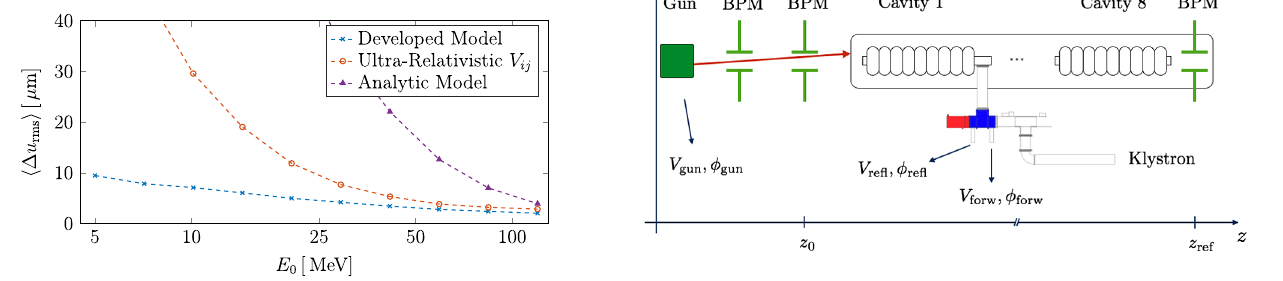
FIG. 6. Schematic drawing of the experimental setup at the FIG. 5. Rms difference between the output of the model injector section at FLASH. Two BPMs are located in the drift function and an ASTRA tracking h Δ u as a function of initial space between the gun and the first cavity. The last BPM is rms i beam energy E 0 , evaluated for one cavity and averaged over both located inside the cryogenic vessel and gives the reference offset. transverse planes. The beam transport matrices are calculated with different models. Plotted is the developed model (blue, Eq. (13)), numerical transfer matrices with ultra-relativistic V ij cavities at the (red, cf. [18]) and the analytic model (purple, cf. [12]).